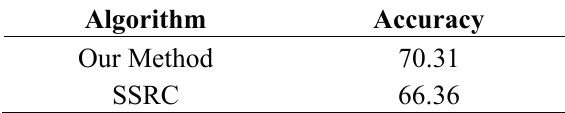
Table 6. Comparative recognition rates for three reference subjects in the MIT